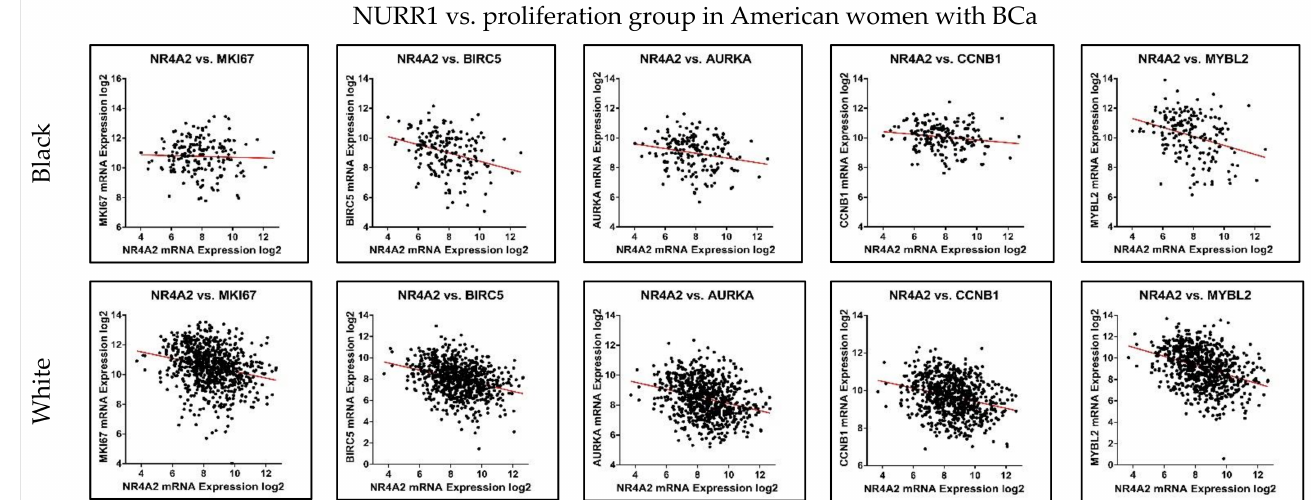
Figure 4. NURR1 expression is positively correlated with Oncotype DX estrogen signaling group. The correlation trend of NURR1 expression with estrogen markers was found to be positive in both Black ( Top row ) and White ( Bottom row ) BCa women. The X and Y -axis represent the log2 of mRNA expression of RSEM batch normalized from illumina HiSeq-RNASeqV2.